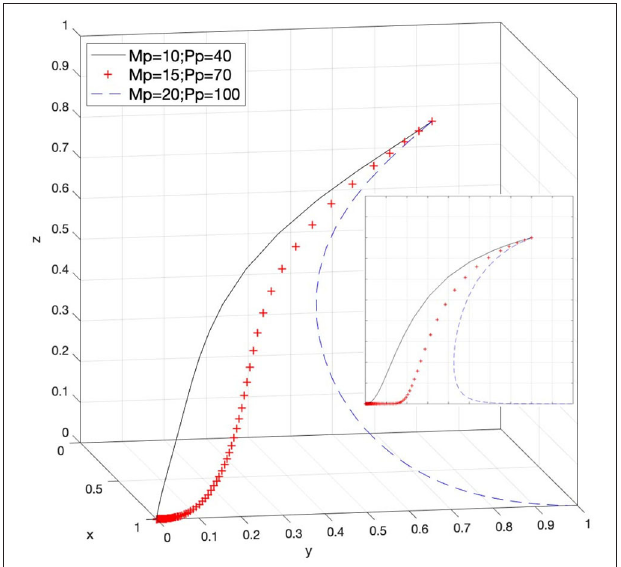
FIGURE 13 | Effects of the rewards for e-commerce platforms’ positive attitude and the fines for infringements within platforms when the government chooses strict